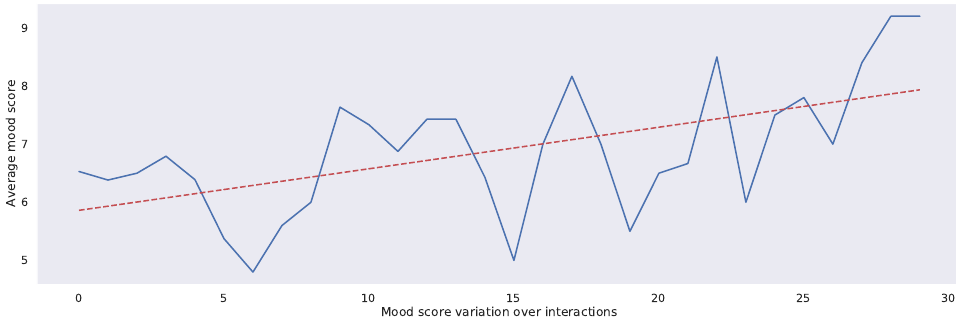
Figure 8. Mean mood score of all study participants over the first nine interactions with Bunji (An interaction is when a user initiates a chatbot function. This can be a conversation, activity, or other chatbot feature). The blue line graph connects the average mood score across each interaction, while the red dotted line depicts the ordinary least squares regression line for these points.